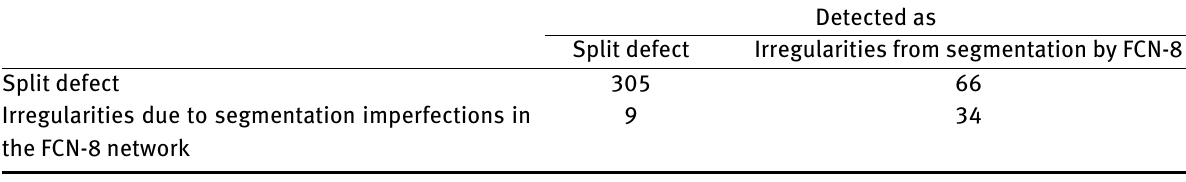
Table 1: Confusion matrix for the split rail defect detection algorithm.